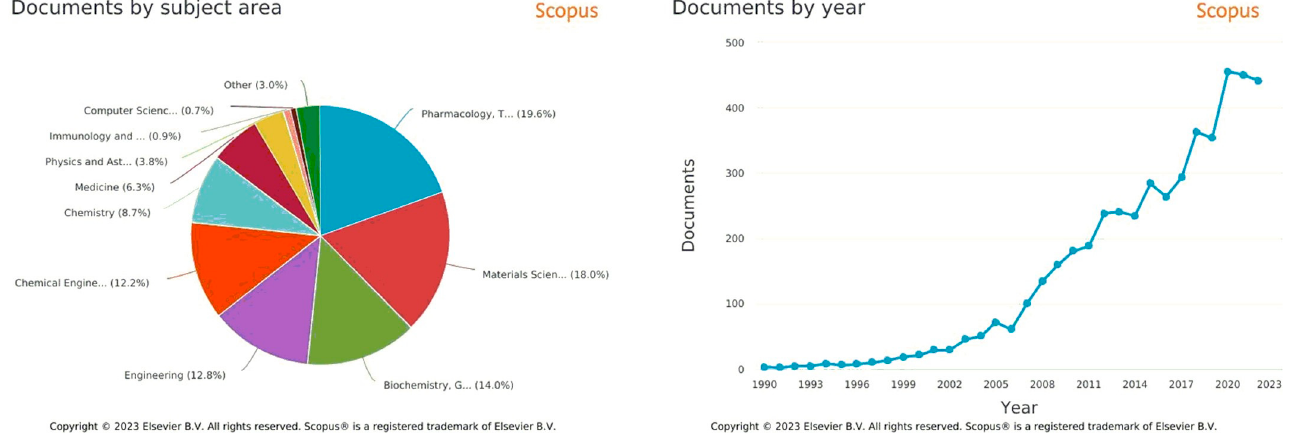
Figure 1. Bibliographic metrics from Scopus (https://www.scopus.com/, accessed on 26 February 2023), with “polycaprolactone multi arms for drug delivery” keywords, from 1990 to 2022.